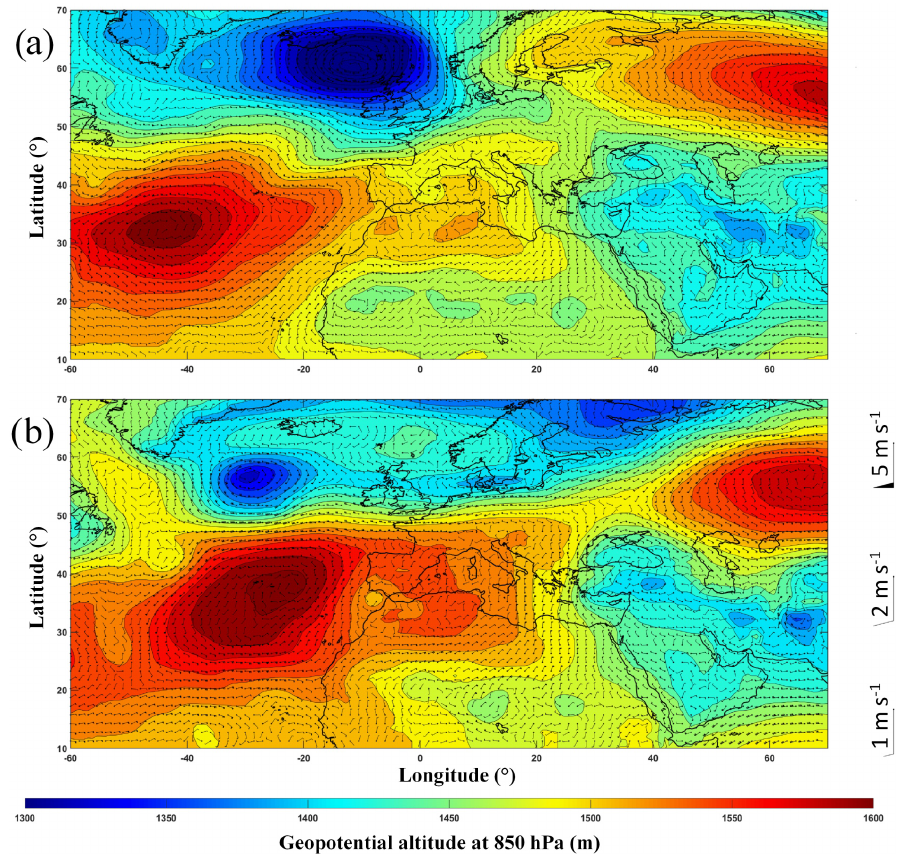
Figure 10. Geopotential altitude at 850hPa on (a) 13 August 2011 at 18:00UTC and (b) 11 August 2011 at 18:00UTC. The wind fields at the same pressure level are superimposed. The ERA5 reanalyses (https://www.ecmwf.int/en/forecasts/datasets/archive-datasets/ reanalysis-datasets/era5, last access: 14 August 2020) with a horizontal resolution of 0.25 ◦ are